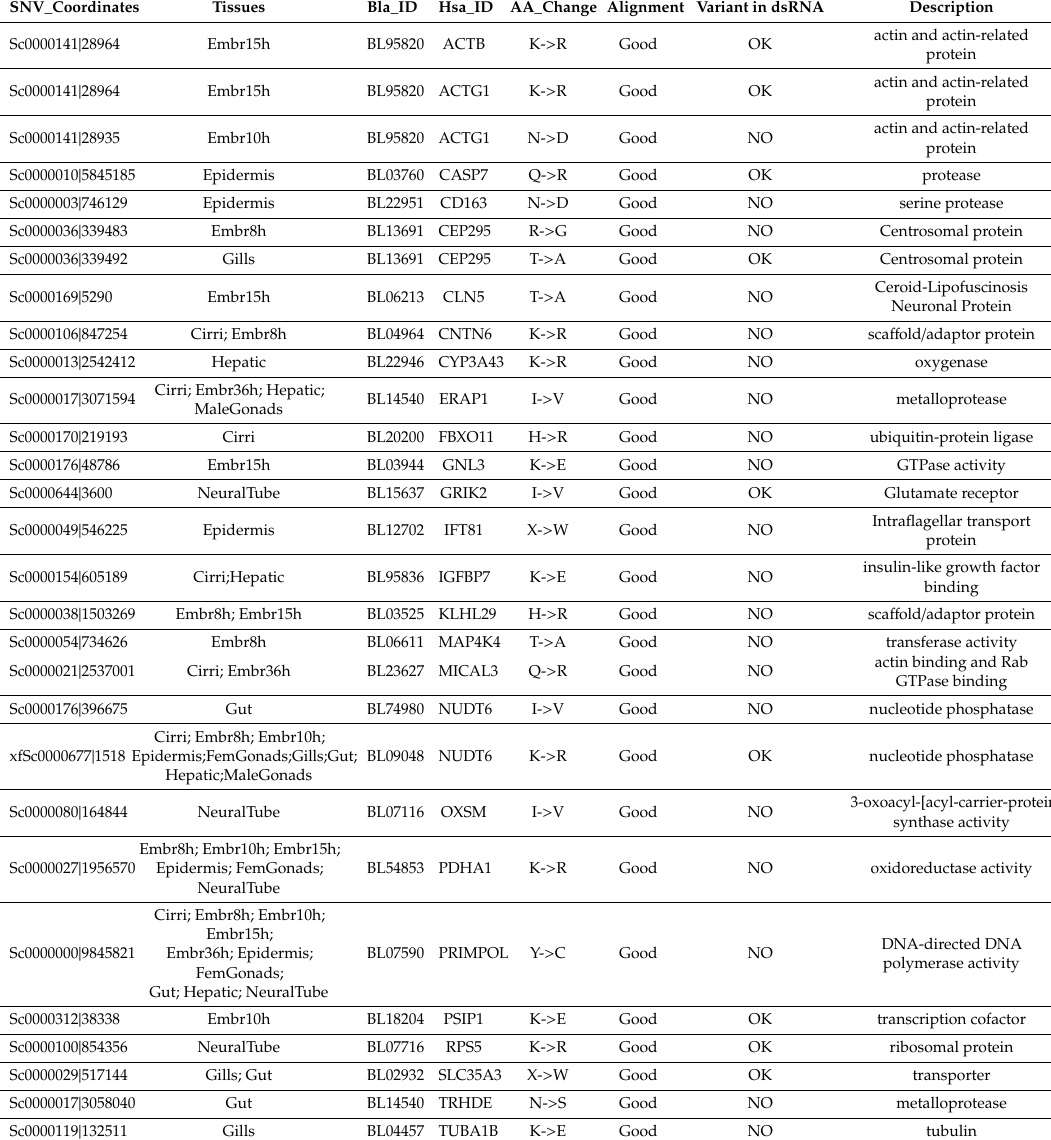
Table 2. Selected windows size 0 class 1 RNA-editing